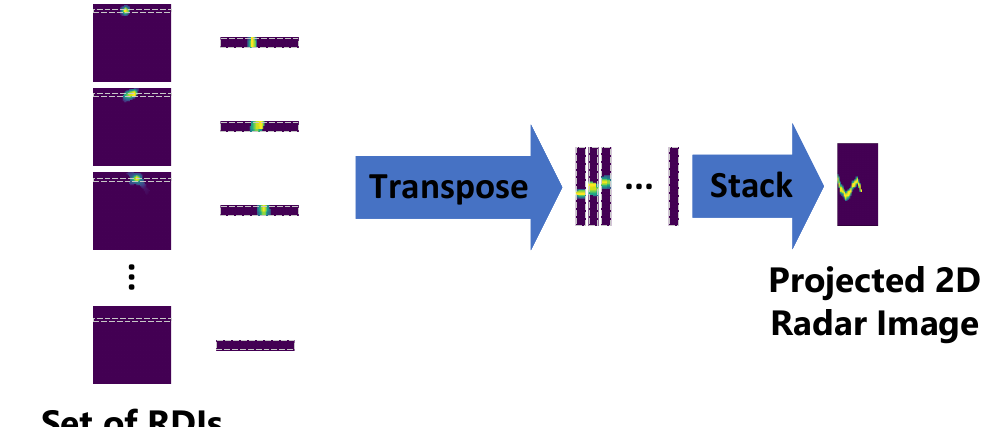
Figure 5. Projection of the extracted RDIs into 2D radar